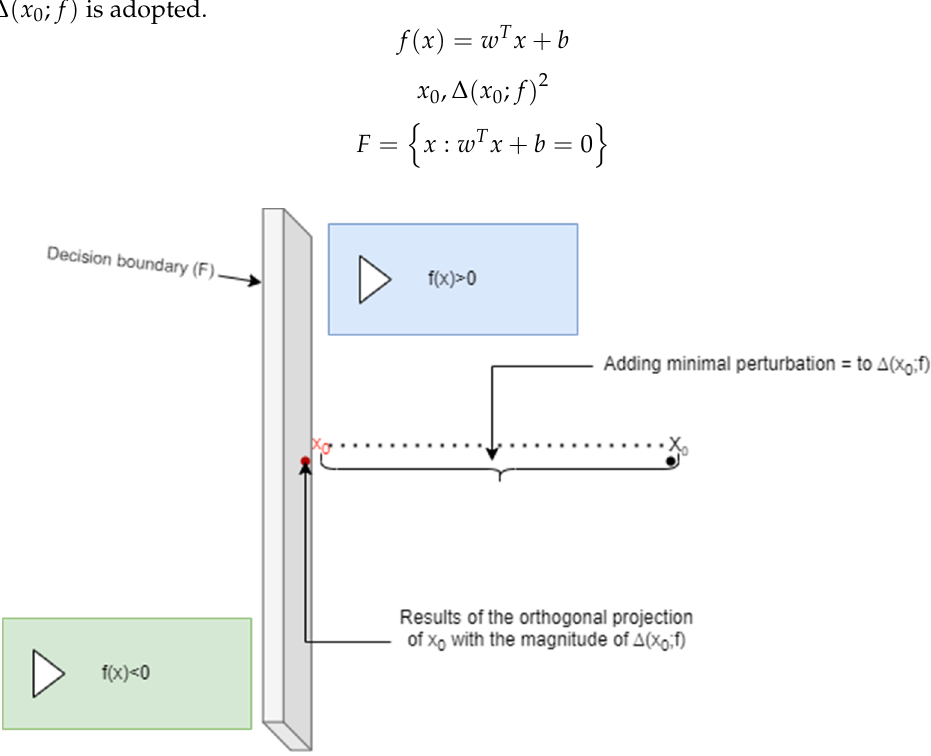
Figure 4. DeepFool adversarial examples for a linear binary classifier illustration.